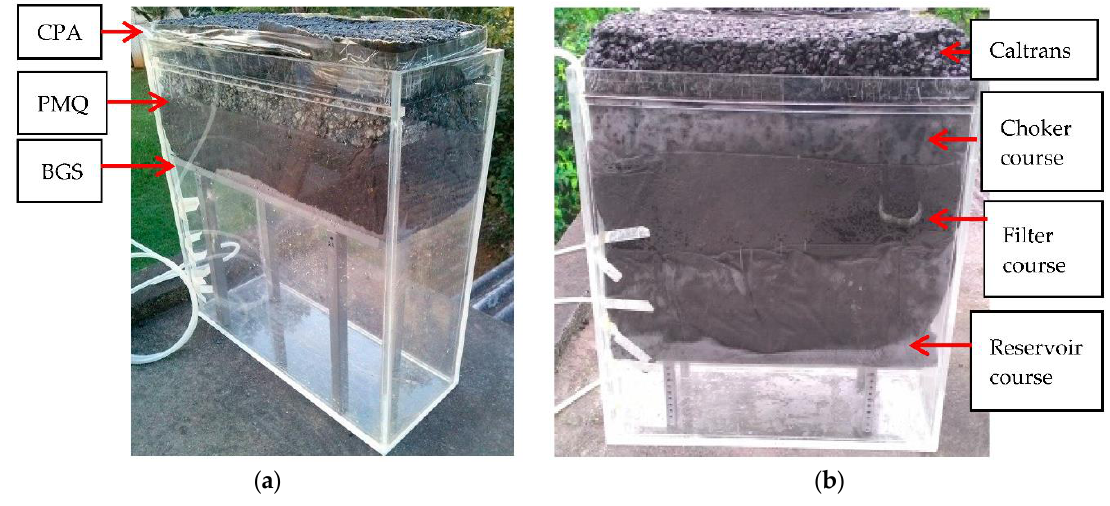
Figure 4. Models assembled in the boxes. ( a ) Model A; ( b ) Model B.